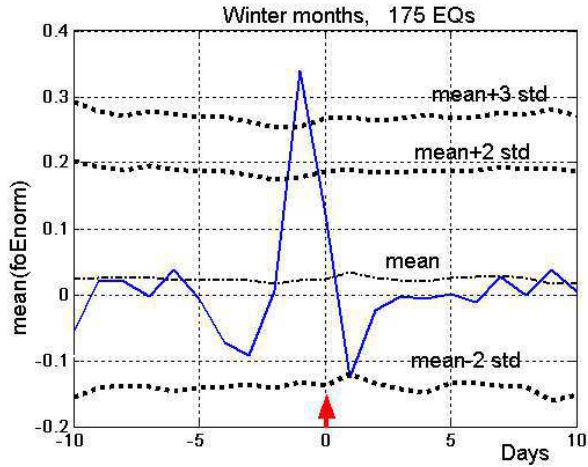
tance from the epicenter. Distances are given in kilometers. The er- ror bars describing ± std are also drawn in. The values of foE norm